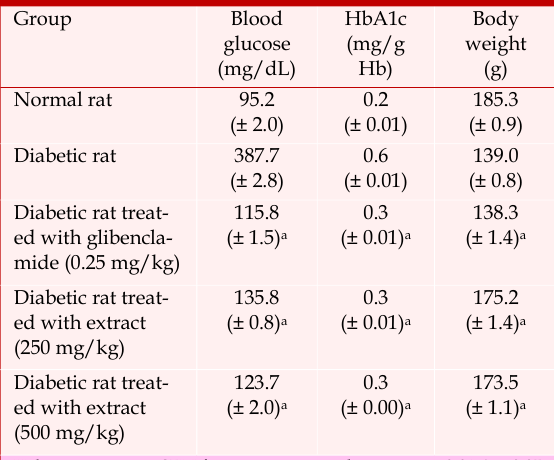
Effect of S. sesban extract on blood glucose, glycosyl- ated hemoglobin and body weight in diabetic